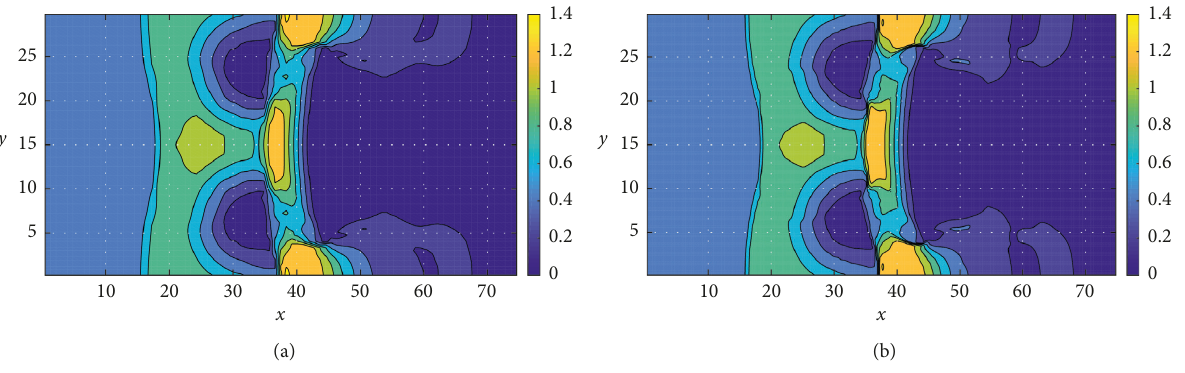
85 (a) and 170 170 (b) grid cells of a dam-break flow over three humps at t × ×